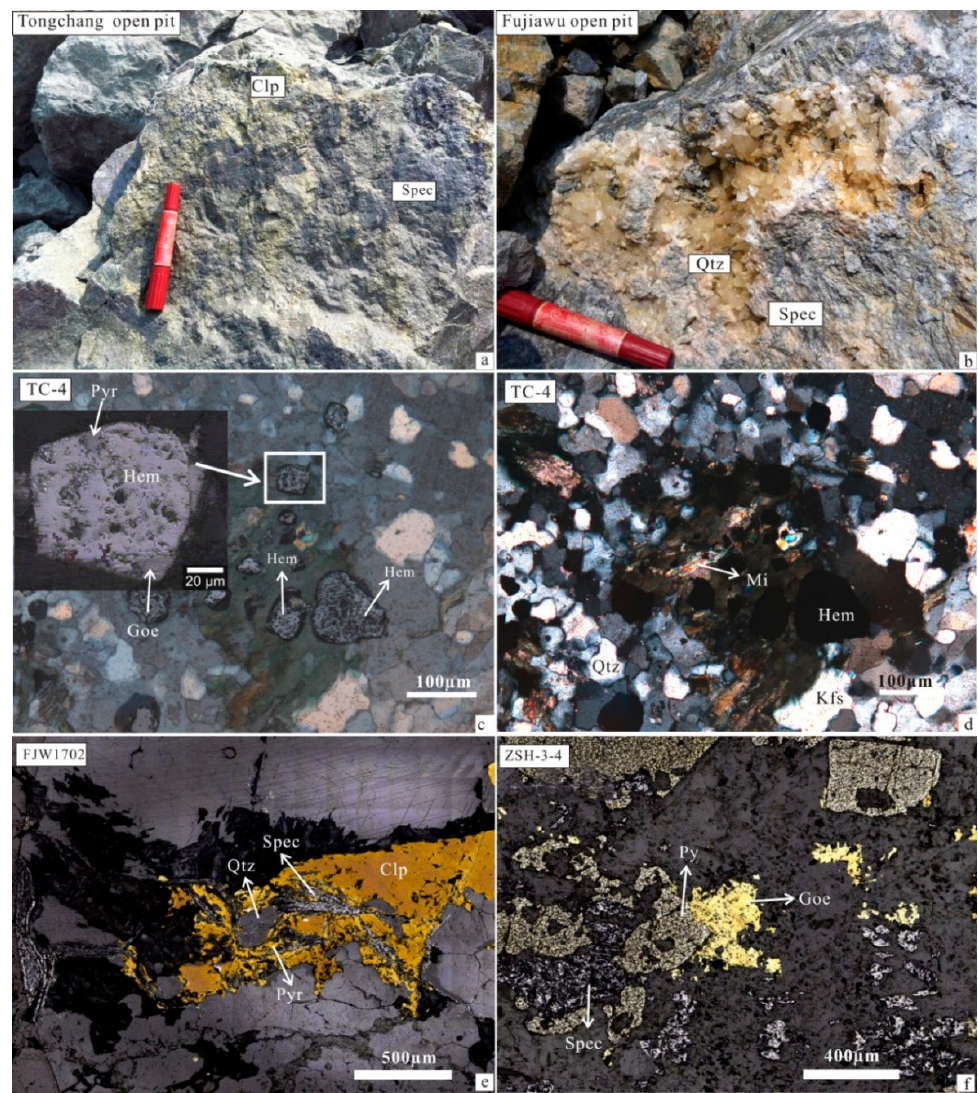
Figure 2. Representative porphyry and mineral combination types of Dexing porphyry copper deposit. ( a ) Specularite and chalcopyrite in the Tongchang porphyry; ( b ) quartz vein and specularite in Fujiawu open pit; ( c ) reflected light pictures showing sulfides and oxides in the Tongchang porphyry; ( d ) transmission pictures of different minerals in the Tongchang porphyry; ( e ) sulfide veins from Fujiawu drill hole consists of Qtz, Spec, Clp, and Pyr; ( f ) the sulfide and oxides combination contains Py, Goe, and Spec from Zhushahong drill hole (Qtz, quartz; Clp, chalcopyrite; Goe, goethite; Hem, hematite; Kfs, K-feldspar; Mi, Muscovite; Py, pyrite; Pyr, pyrrhotite; Spec, specularite).